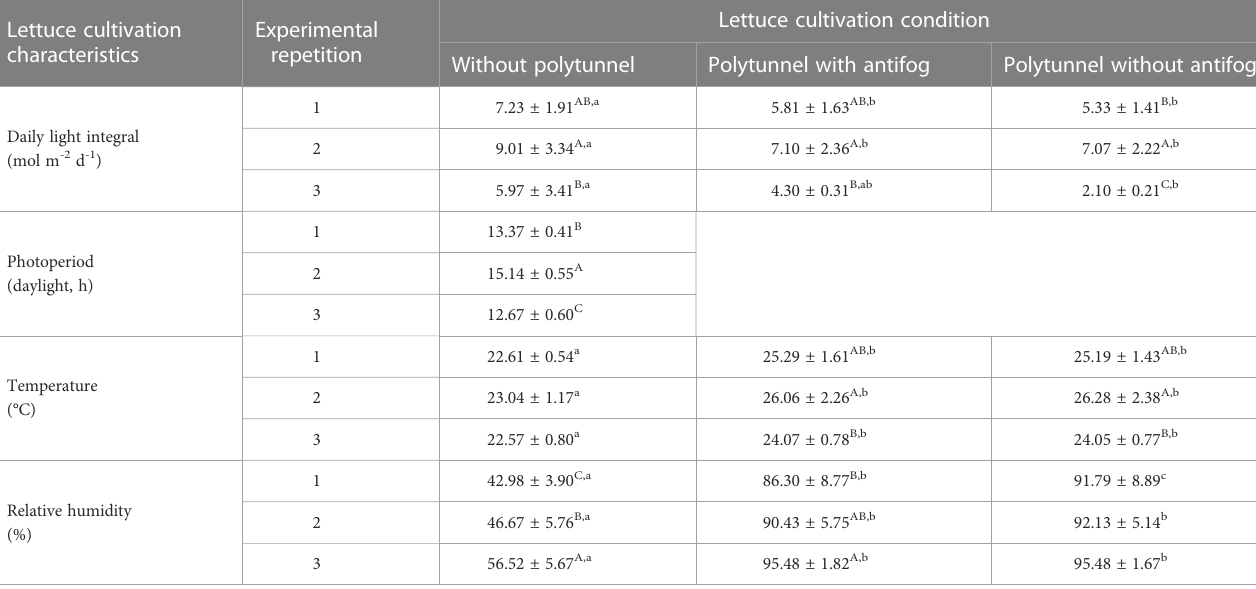
TABLE 1 Lettuce cultivation characteristics of three independent experimental repetitions in April (1), May (2) and September (3).